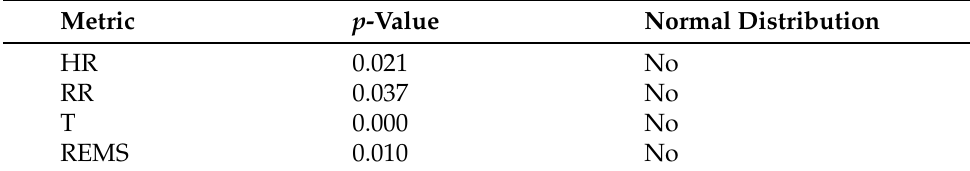
Table 5. Results of Kolmogorov–Smirnov test for metrics without the system.